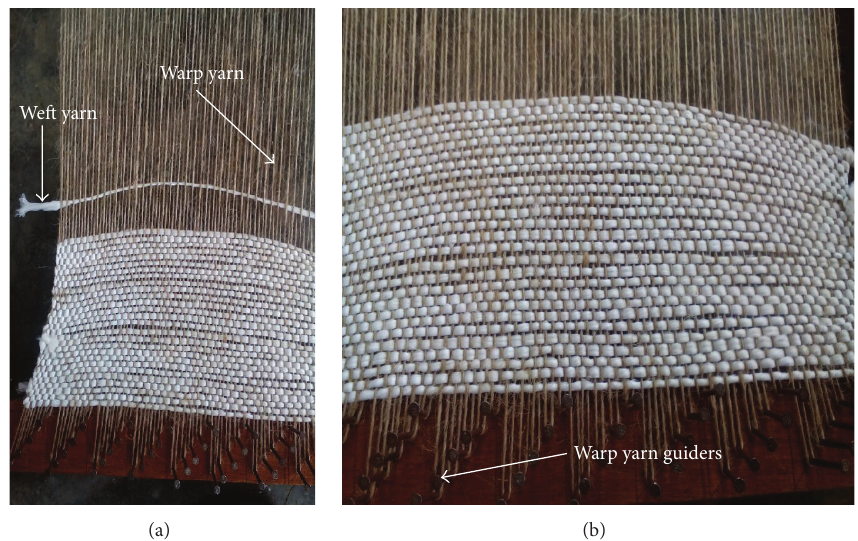
Figure 1: Arrangement of yarns on the weaving platform. (a) Weaving platform showing warp and weft yarn. (b) Woven fabric supported by warp yarn guiders on the platform.